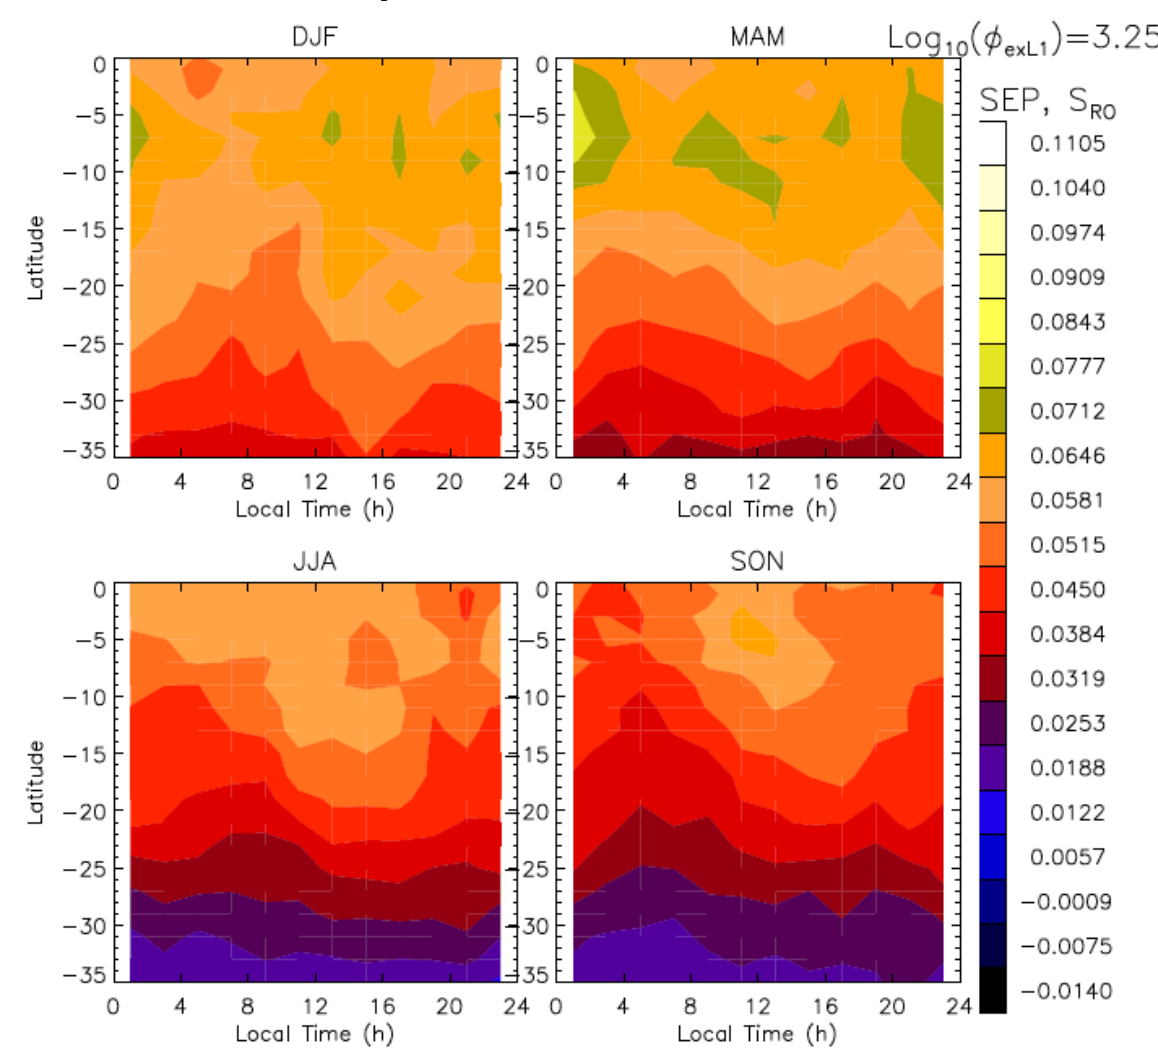
Figure 12. Diurnal variations of COSMIC-1 S RO at Log 10 ( f exL1 ) = 3.25 for the SEP region (105° W–75° W). The data from 2008–2013 are averaged into 2-hourly bins to derive the four seasonal climatology at latitudes between 35° S and the equation.